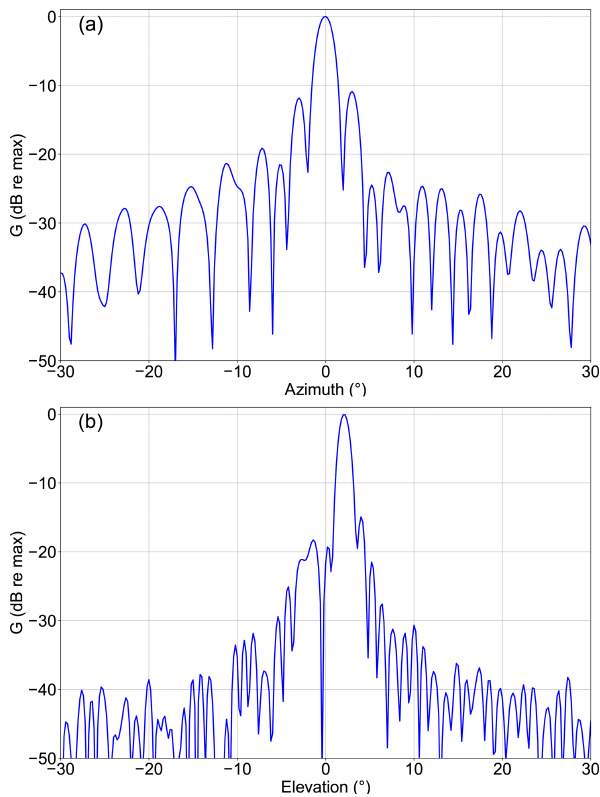
Figure C3. KaRADOC radiation diagram at 33.7GHz as a func- tion of (a) azimuth at 2.09 ◦ elevation and (b) elevation at − 0.05 ◦